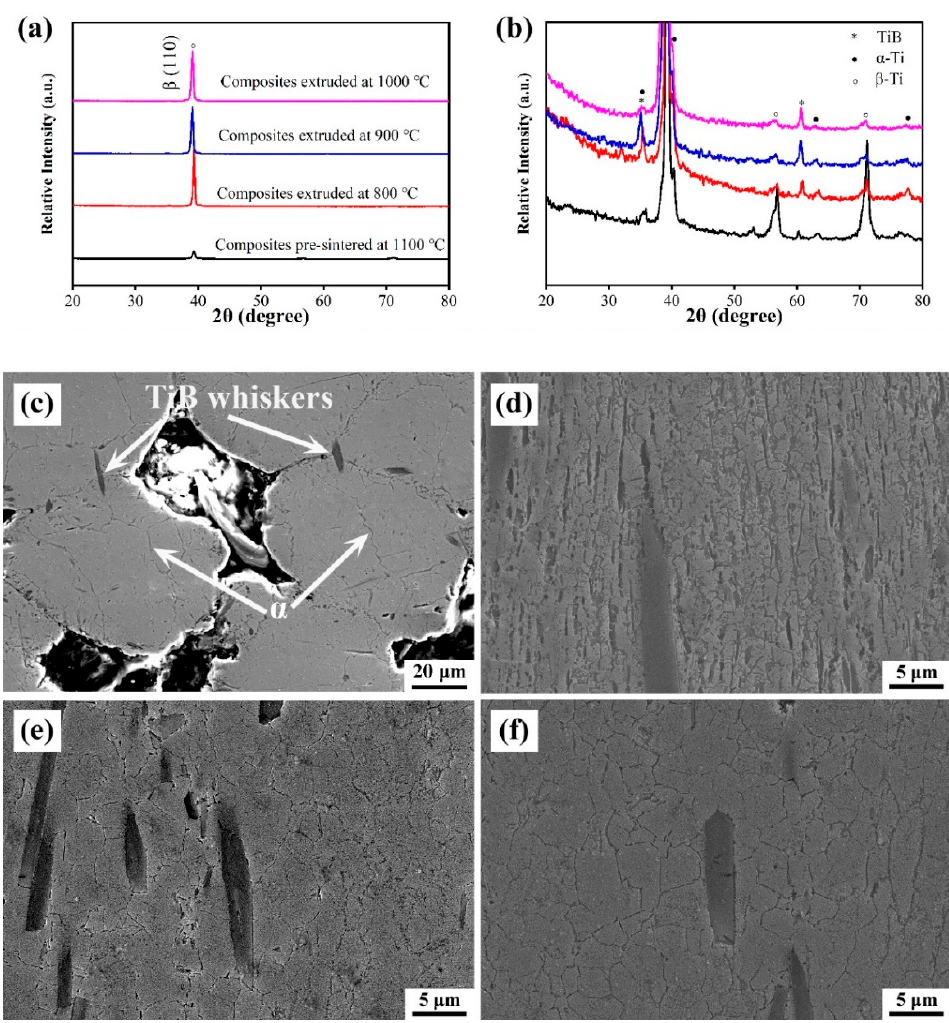
Figure 1. The XRD of pre-sintered and as-extruded composites ( a ), high magnification of XRD ( b ); SEM images of pre-sintered composites ( c ), composites extruded at 800 °C ( d ), composites extruded at 900 °C ( e ), composites extruded at 1000 °C ( f ).